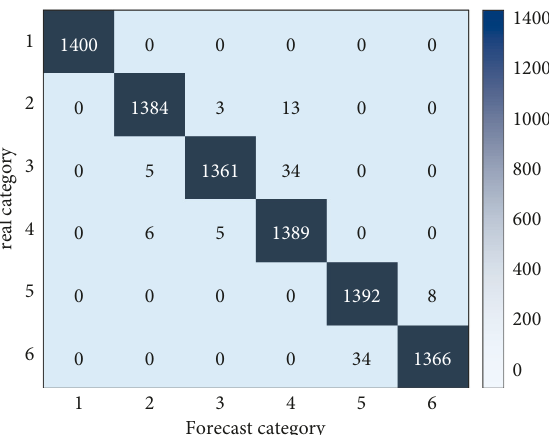
Figure 10: Individual identification results of stacking mobile